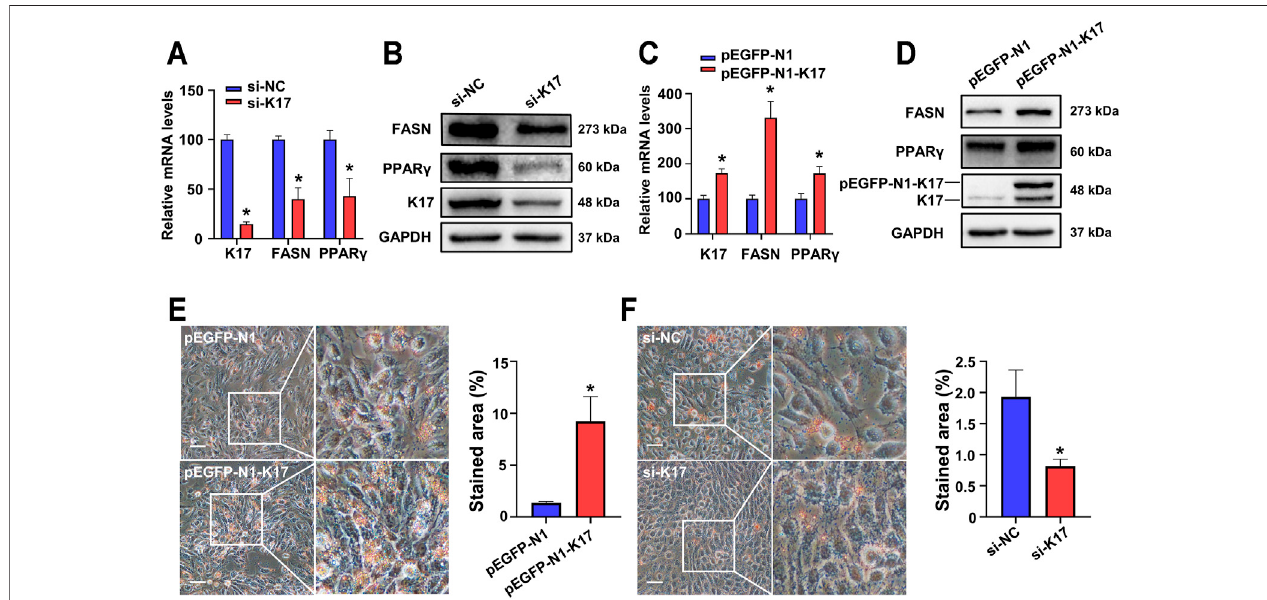
FIGURE 4 | K17 in keratinocytes maintains and regulates FASN and PPAR γ expression. (A,B) The mRNA and protein levels of K17, FASN, and PPAR γ in the keratinocyte cell line HaCaT were measured after transfection with K17 siRNA. (C,D) The mRNA and protein levels of K17, FASN, and PPAR γ in HaCaT cells were measured after transfection with pEGFP-N1-K17. Data are expressed as means ± standard error of the mean of three independent experiments. (E,F) Lipid droplets in HaCaT cells transfected with pEGFP-N1-K17 or K17 siRNA were stained with Oil Red O and visualized by light microscopy at × 400 magni fi cation. Scale bars (cid:1) 50 µm * p <